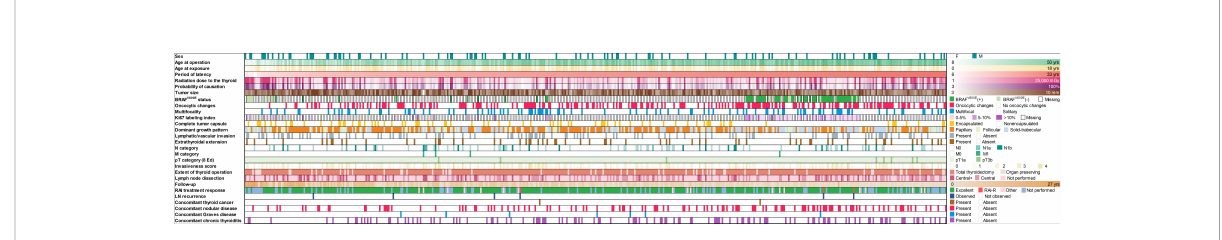
FIGURE 1 Baseline and clinicopathological pro fi le of 465 radiogenic papillary thyroid microcarcinomas in the